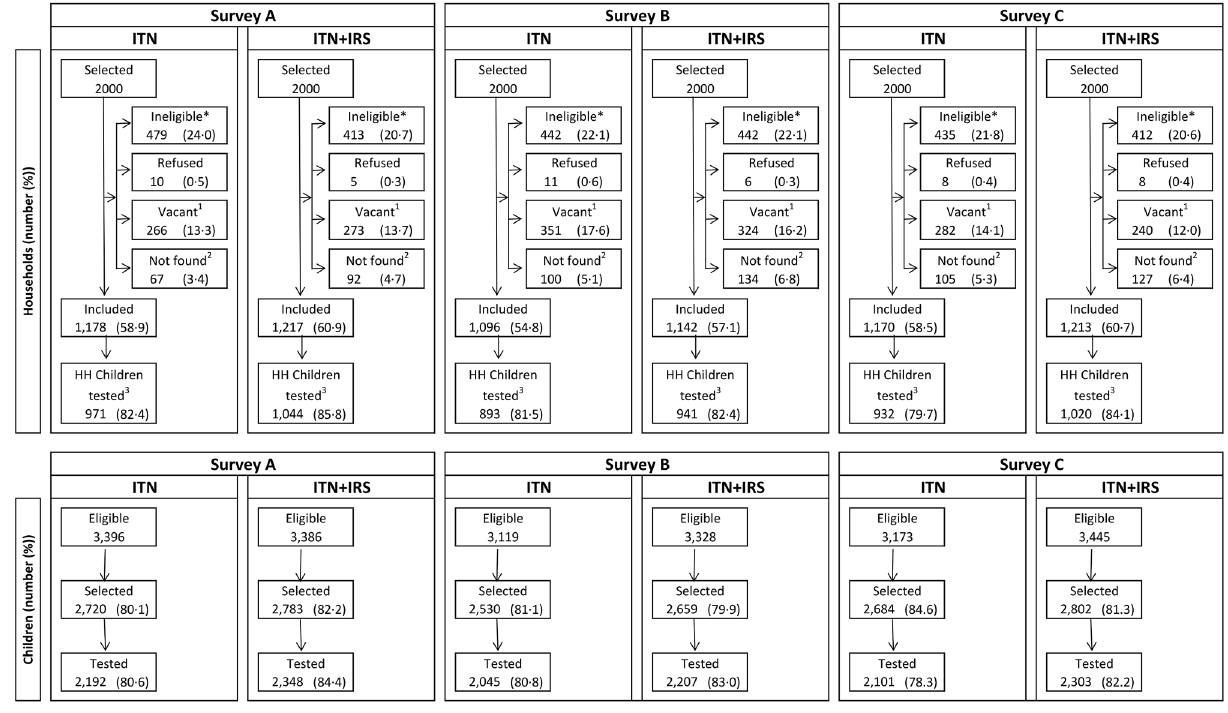
Figure 2. Trial profile for study households and children in the ITN only and ITN + IRS study arms. Survey A=2 mo after first intervention spray. Survey B=6 mo after first intervention spray and 2 mo after second intervention spray. Survey C=10 mo after first intervention spray and 6 mo after second intervention spray. *No children 0.5–14 y old. 1 Dwelling vacant for survey duration. 2 Includes not found (91.0%), not visited (2.4%), and missing data (6.6%). 3 Households (HH) that were included and where children attended for